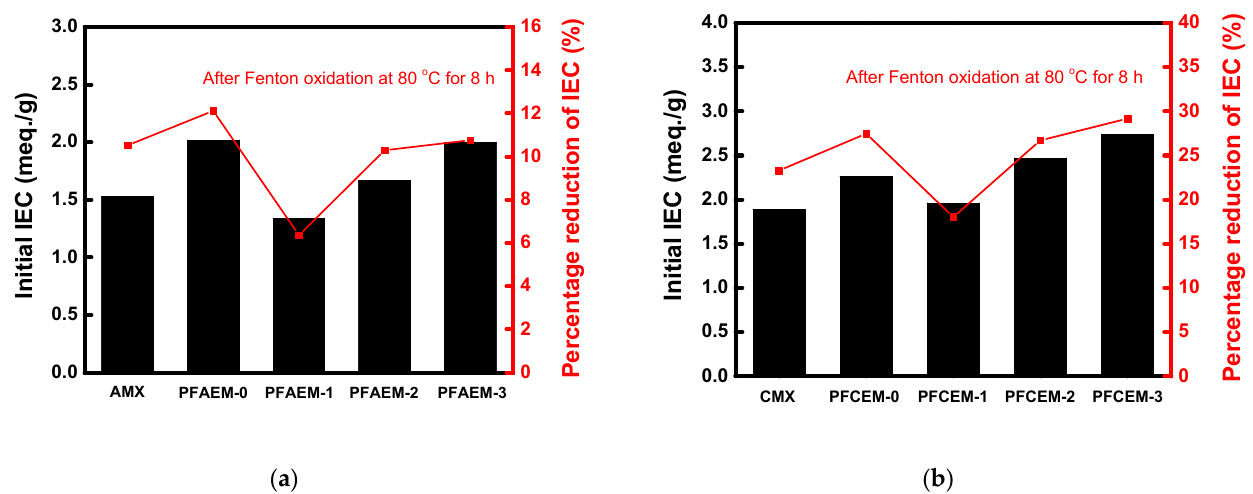
Figure 9. Initial IEC values and percentage reduction of IEC after Fenton oxidation at 80 °C for 8 h of ( a ) AEMs and ( b ) CEMs.